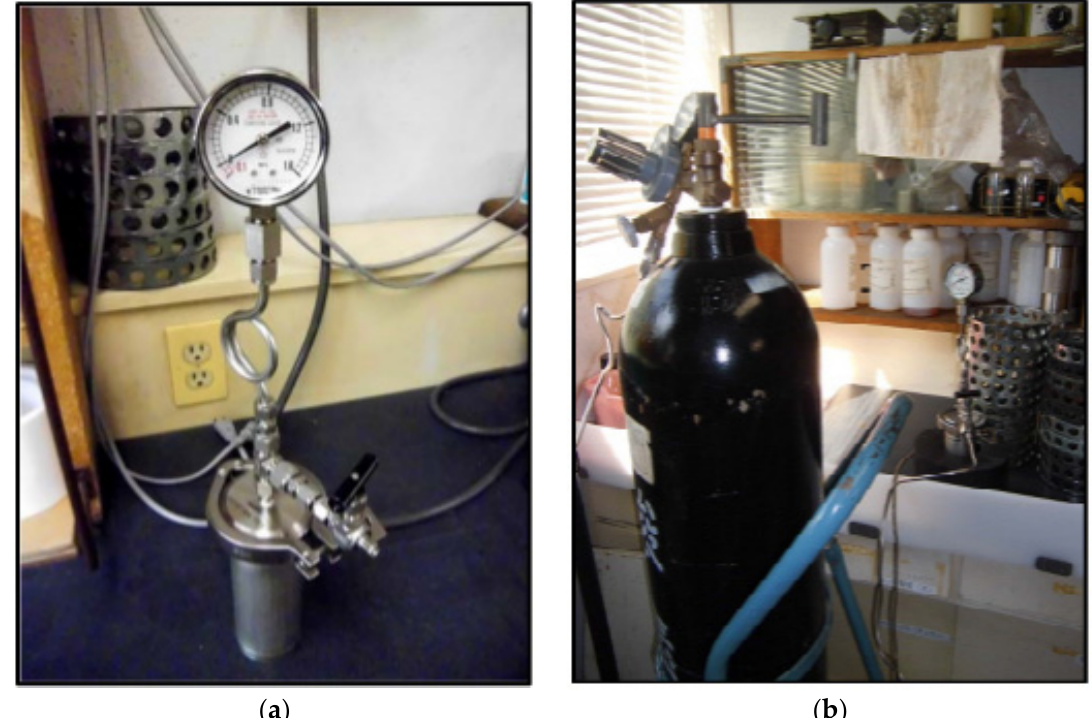
Figure A2. ( a ) Put pulp in a polypropylene plastic bottle, and ( b ) then put the plastic bottle into the reactor.